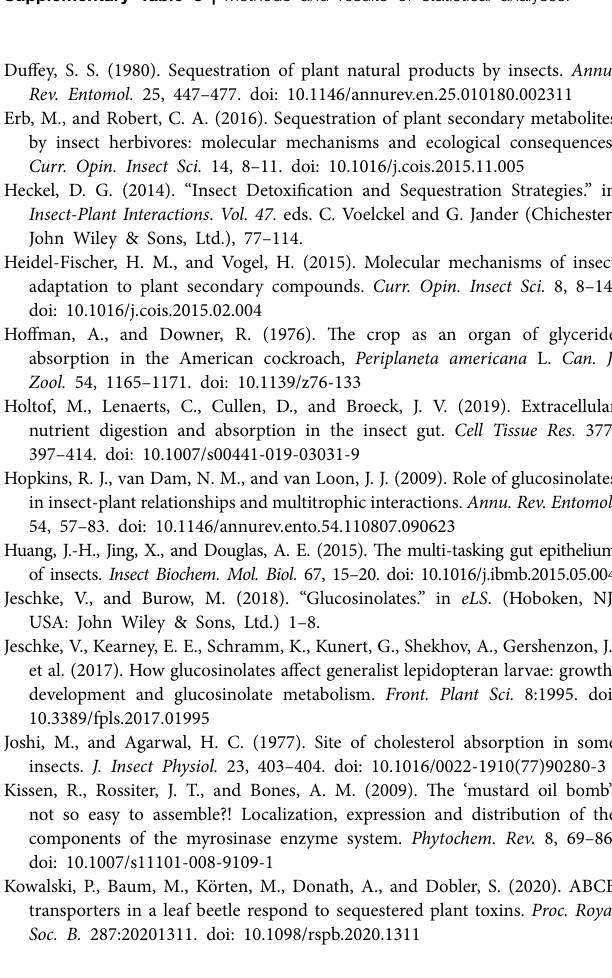
Supplementary Table 1 | Multiple reaction monitoring (MRM) transitions for compounds determined using LC-MS/MS. Supplementary Table 2 | μCT parameters.